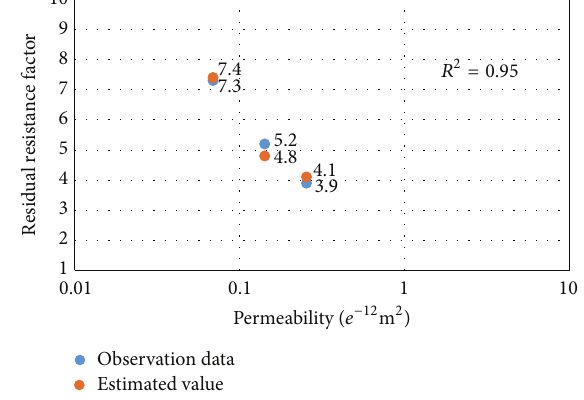
Figure 5: Matching results between observation and estimation using the correlation function of RRF = 𝑎 1 /𝑘 2 + 𝐶 M . Trap +